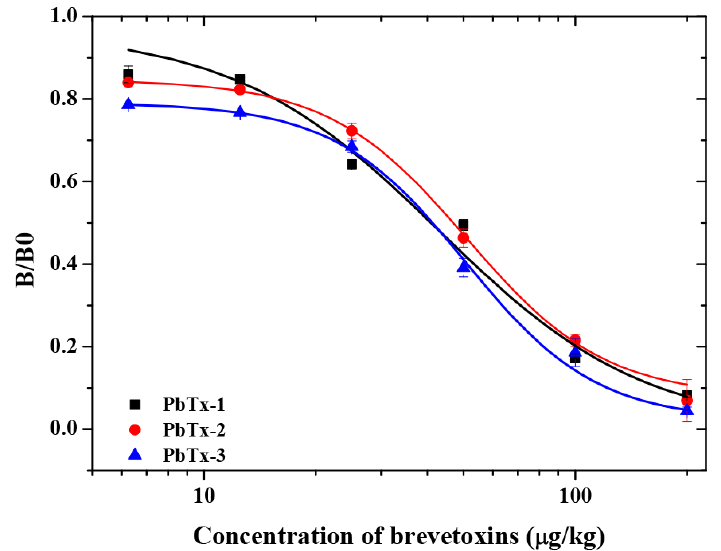
Figure 5. The brevetoxin icELISA standard curve using the mAb 1D3 with the PbTx-2-HS-BSA coating antigen.